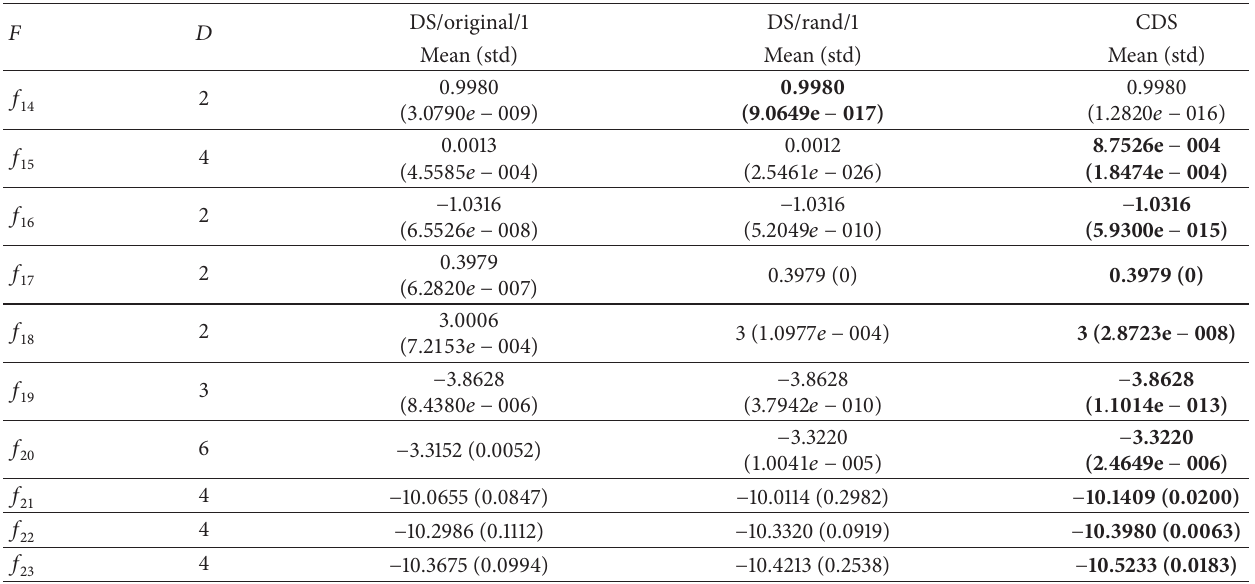
Table 9: The mean and convergence iteration of the functions in Table